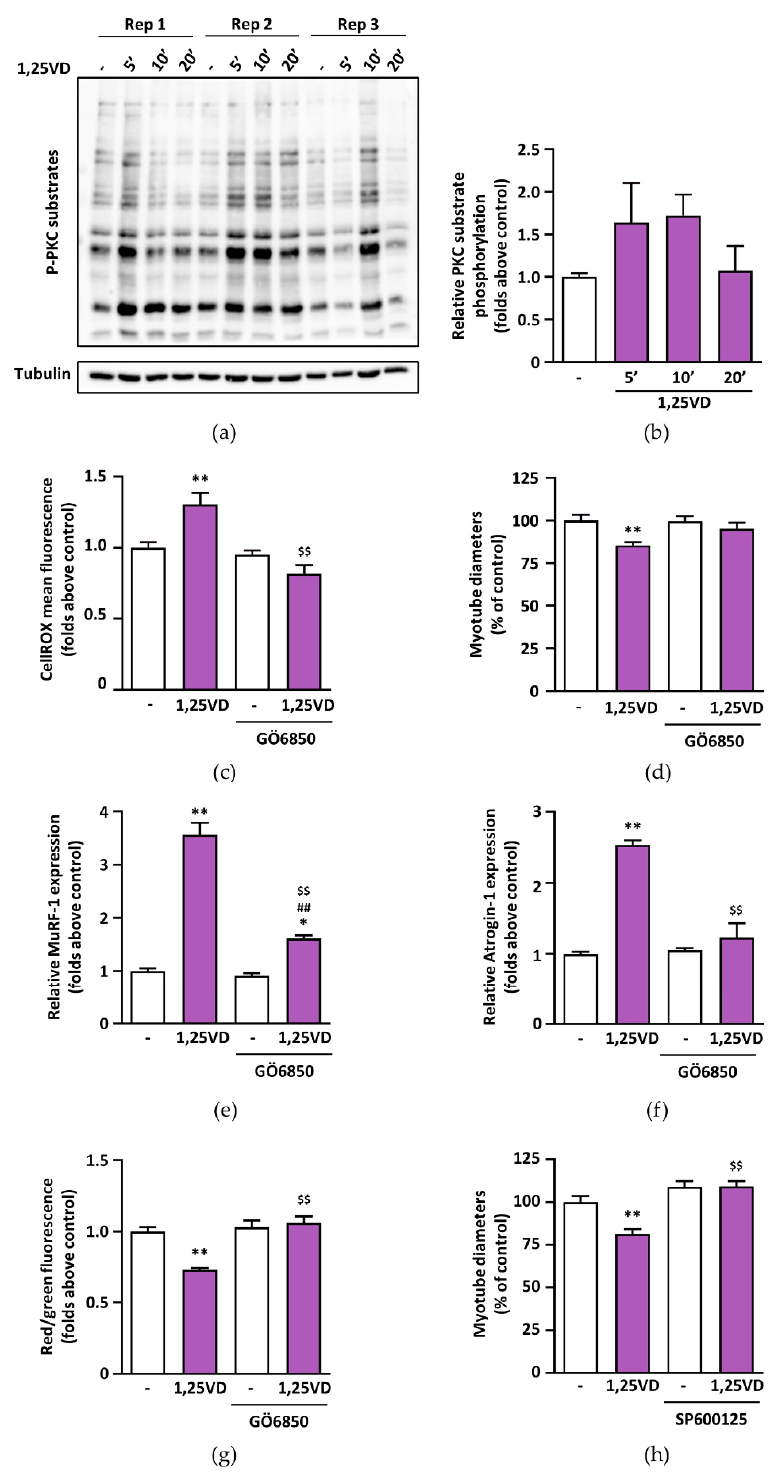
Figure 8. PKC and JNK activation mediates 1,25VD-induced atrophy. C2C12 myotubes were treated in serum-free medium with 100 nM 1,25VD for 5, 10 and 20 min and ( a ) PKC activation was assessed by western blot of its phosphorylated substrates. ( b ) Densitometry of P-PKC substrates normalized on tubulin. To investigate whether PKC is involved in 1,25VD-induced atrophy, C2C12 myotubes were treated in serum-free medium with 100 nM 1,25VD in the presence or absence of 1 μ M GÖ6850, a specific PKC inhibitor, for 24 h. At the end of the treatments, ( c ) ROS levels were evaluated